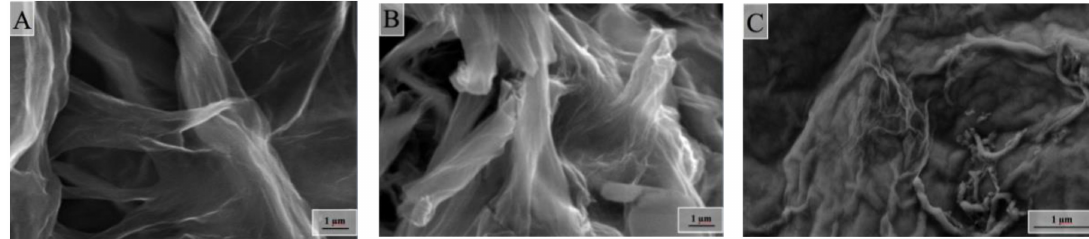
Figure 5. Micrographs ( A – C ) of light sample of composite graphene / multi-walled carbon nanotubes (MWCNTs) aerogel at the same magnifications.